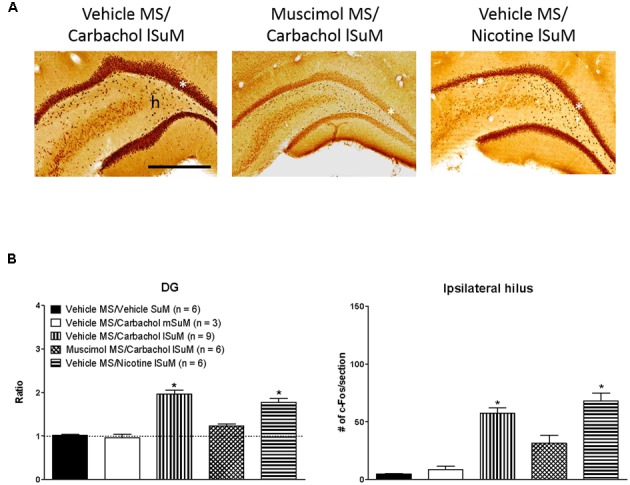
Medial septum modulates lSuM-induced expression of c-Fos-ir in the ipsilateral dentate gyrus (DG). (A) Digital images showing c-Fos-ir in coronal sections taken through the dorsal DG (posterior ∼3.00 mm from Bregma). White asterisk on the figures indicates the granule cell layer. Note that the granule cell layer is densely packed with c-Fos-ir in Vehicle MS/Carbachol lSuM and Vehicle MS/Nicotine lSuM groups, but is almost absent in the Muscimol MS/Carbachol lSuM group. A similar pattern of induction of c-Fos-ir is observed in the hilus (h). (B) Histograms illustrating changes in the level of c-Fos-ir in DG granule cell layer (DG on the figure) and ipsilateral hilus on microinjection into MS and SuM. c-Fos-ir in the granule cell layer was quantified by estimating the ROD since the labeling was very dense in the DG. The intensity of label on the ipsilateral side was expressed as the ratio of the ROD on the ipsilateral side to the contralateral side. A ratio of 1 (marked by horizontal dotted line) indicates comparable ROD on the ipsilateral and the contralateral side. The histograms are built as in Figure 3. Data are mean ± SEM. Significant difference (p < 0.05): ∗ vs. Vehicle MS/Vehicle SuM and Vehicle MS/Carbachol mSuM. Statistical analyses were performed using Kruskal–Wallis statistic followed by Dunn’s Multiple Comparison Test. Scale bar represents 1.0 mm.